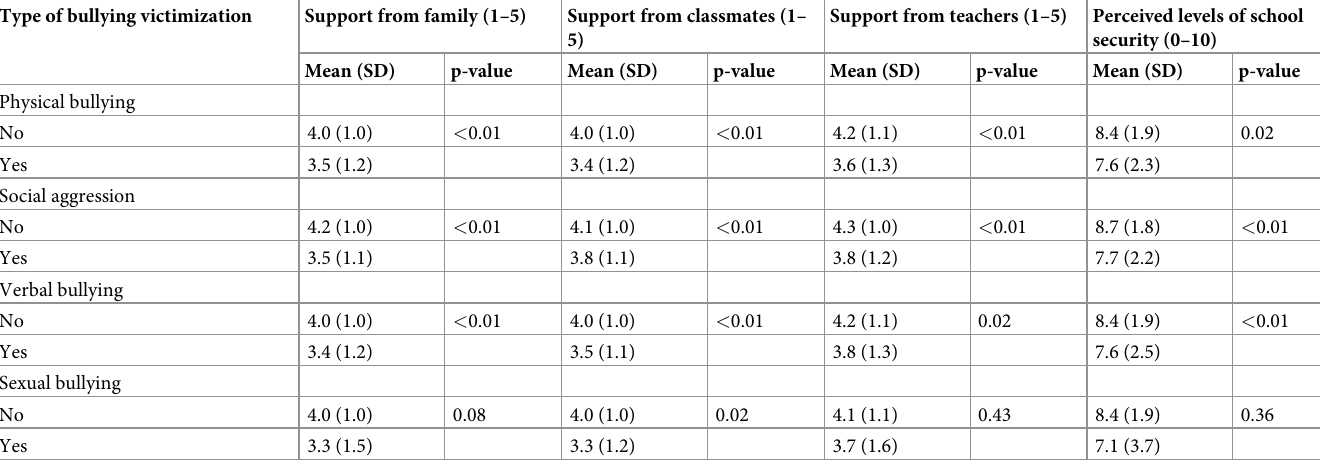
Table 3. Type of bullying victimization and supports from family, classmates, and teachers.